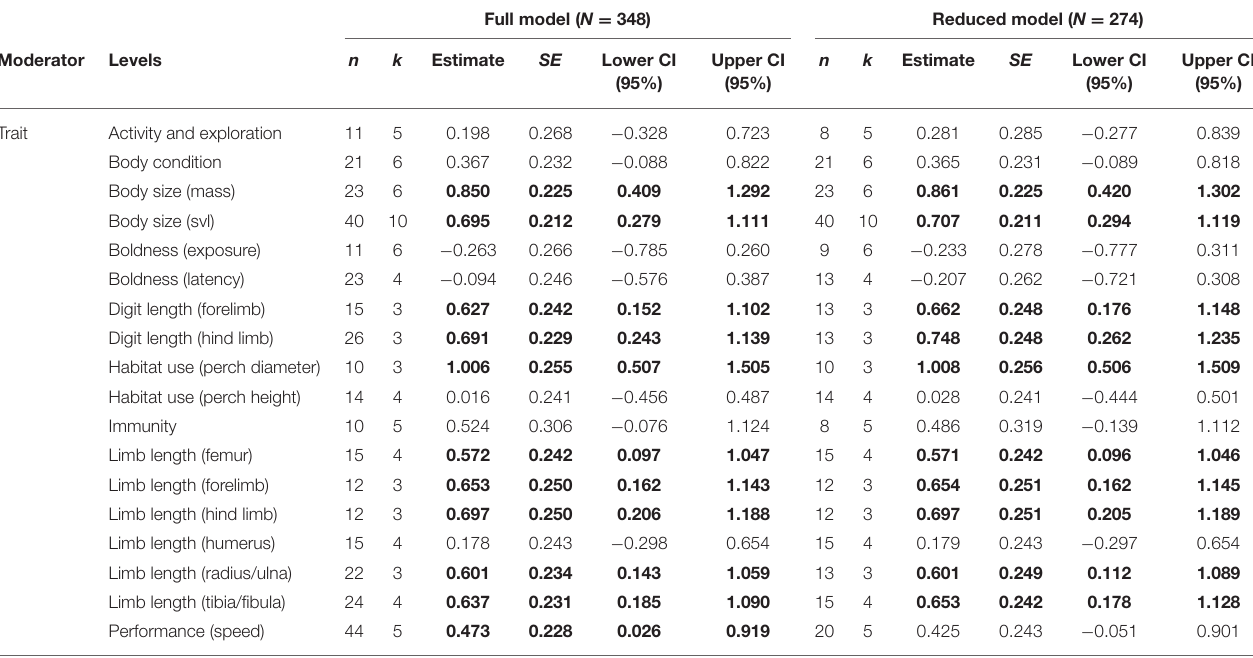
TABLE 1 | Summaries of the meta–regression models with significant results shown in bold ( n , number of effect sizes; k , number of lizard species). Full model ( N =